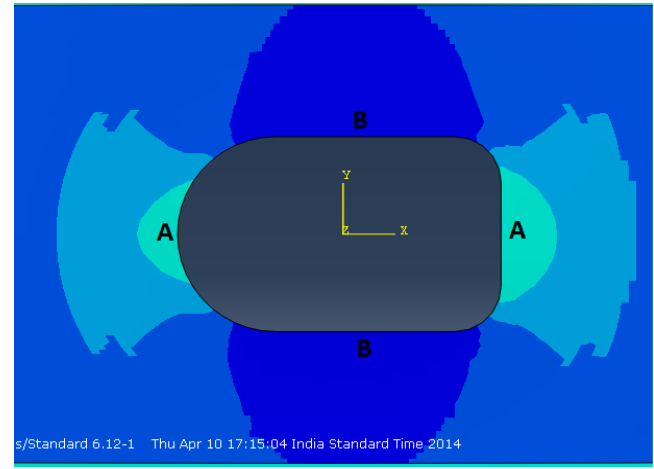
Figure 8. Highly stressed regions on the panel (near the cutout). Region B was impacted with a sharp impactor (Figure 9), as it is likely to cut fibers in the panel, which are critical for carrying normal stress. Region A was impacted with a blunt hemispherical impactor, as it is likely to result in delamination in layers/plies with minimal breakage of fibers. Such a damage scenario can lead to increased shear stresses around the damaged area, representing the worst type of damage for both regions. Testing the damage tolerance of the panel in this worst-case scenario is expected to prove its tolerance of other less-critical damage.